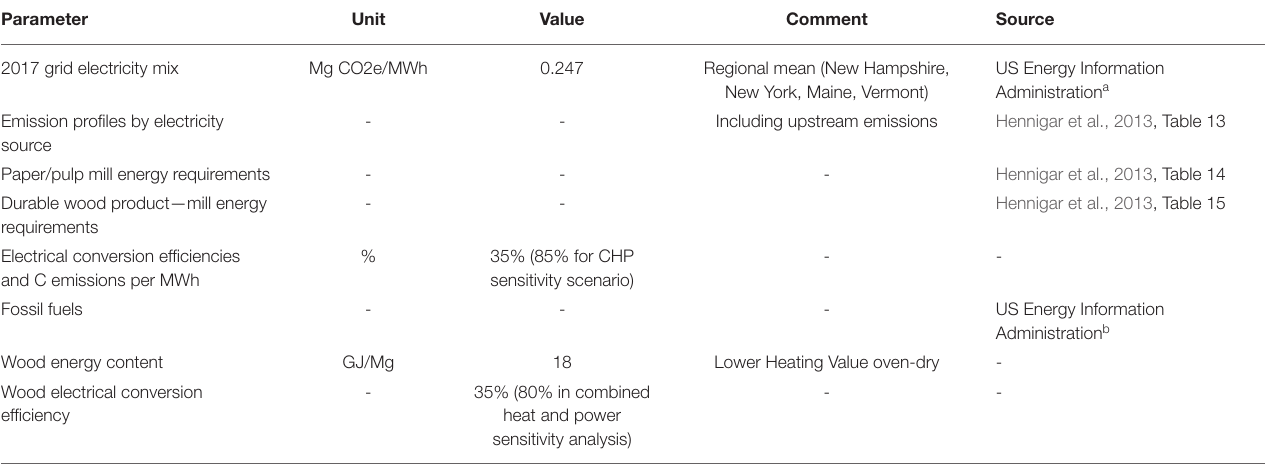
TABLE 4 | Carbon life cycle assessment input parameters for electricity generation from pulp